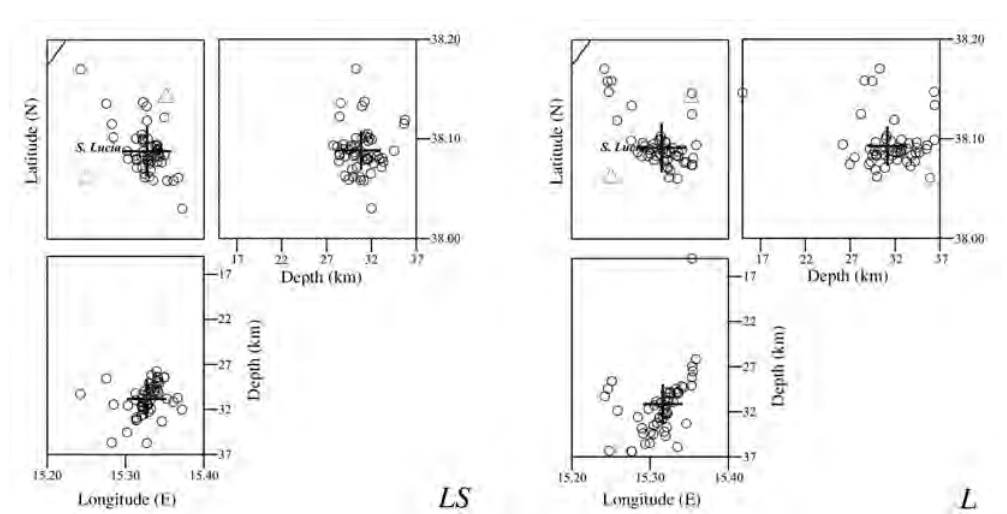
Fig. 4. Epicentre locations and hypocentre depth distribution of the Santa Lucia swarm obtained using the 3D model by Neri et al. (2002) and the data from the integrated network (configuration LS , left panel) and the land- based network (configuration L , right panel). Triangles and crosses indicate the stations lying in the swarm area and the barycentres used for estimates of the D xy and D xyz dispersion factors (see eqs. (3.1) and (3.2) in Section